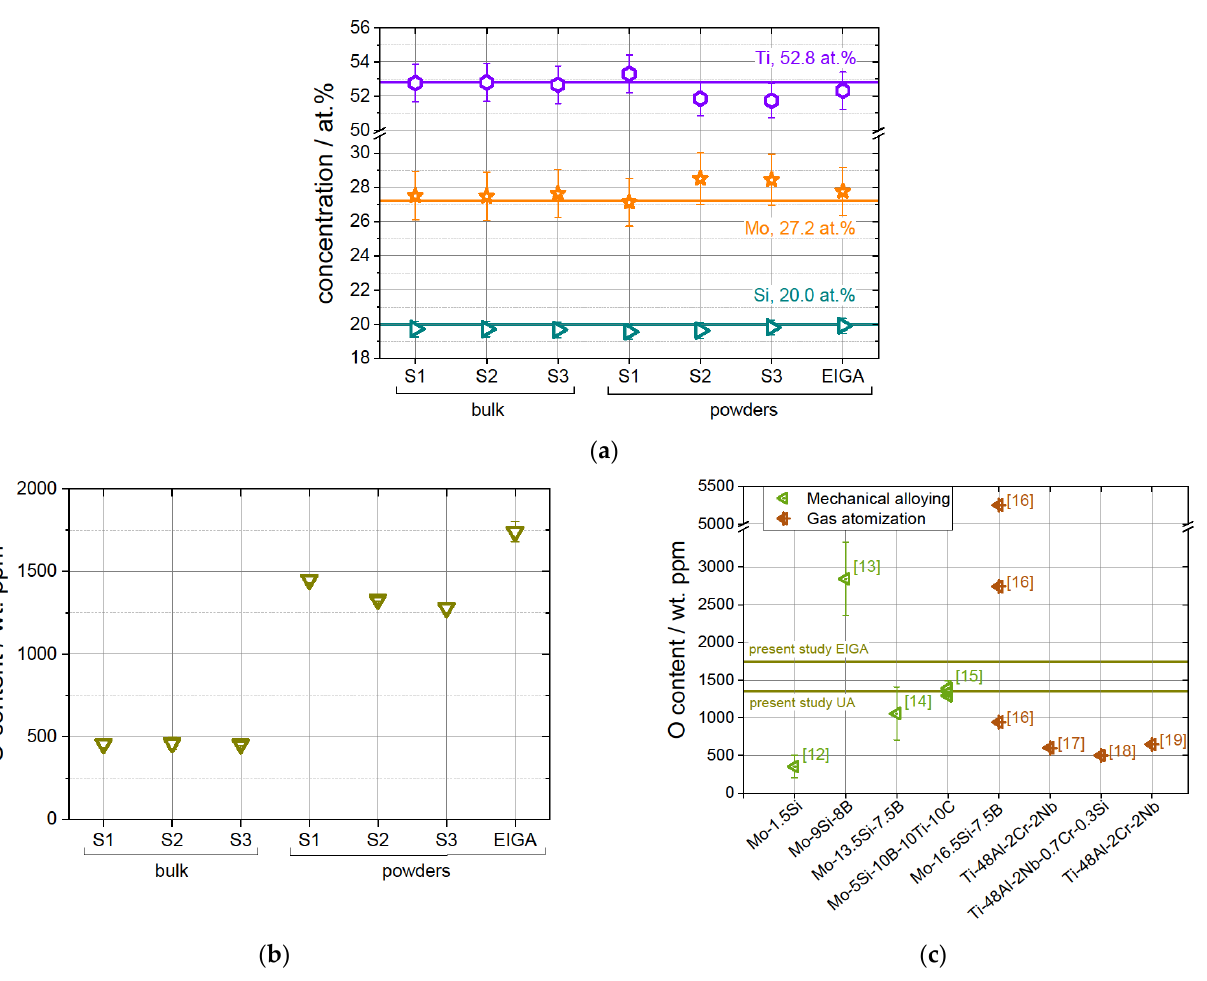
Figure 5. Alloy composition by ICP-OES in the arc-melted as-cast state (bulk) and after atomization ( a ), O contents by CGHE ( b ), and O contents of powders of several Mo- and Ti-containing powders reported in the literature [12–19] ( c ).